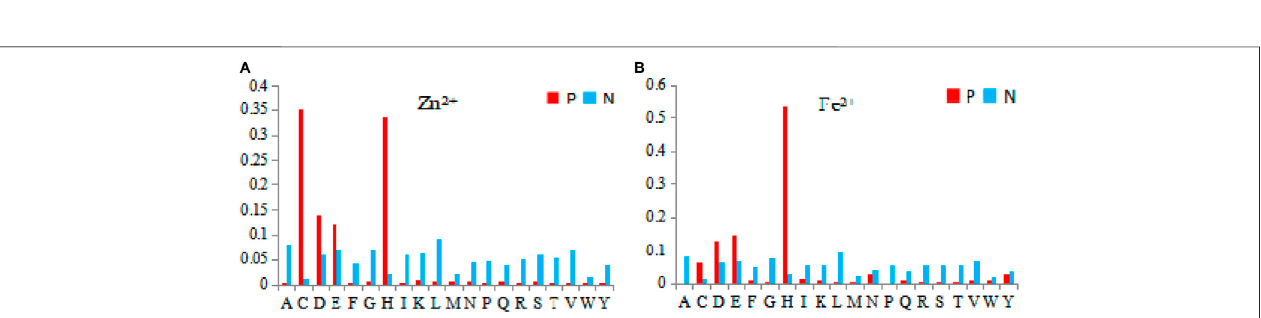
FIGURE5| The probabilityof20aminoacidsin Zn 2+ and Fe 2+ bounding residues. Note: The abscissa valuesrepresents20amino acids,theletters ofanalphabet in ordinate represents the probability. P represents the binding residue, and N represents the non-binding residue.